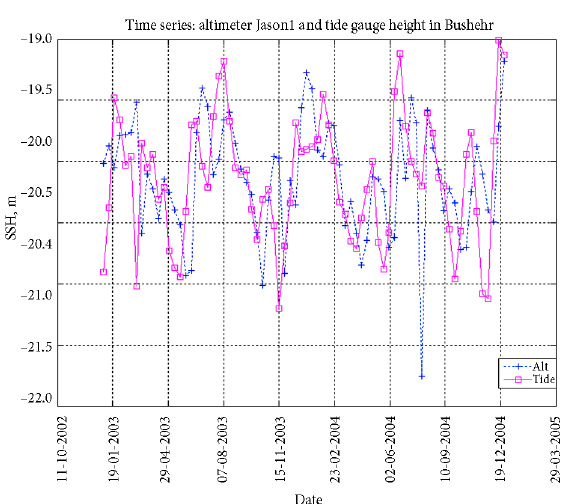
Fig. 6. SSH time series obtained from jason-1 versus those of Bushehr tide gauge over a 2-year time span from 2003 to 2005 Fig. 3. Altimetry SSH time series at Bushehr port derived from Topex/Poseidon, jason-1 and jason-2 over a 22-years span from 1993 to 2014